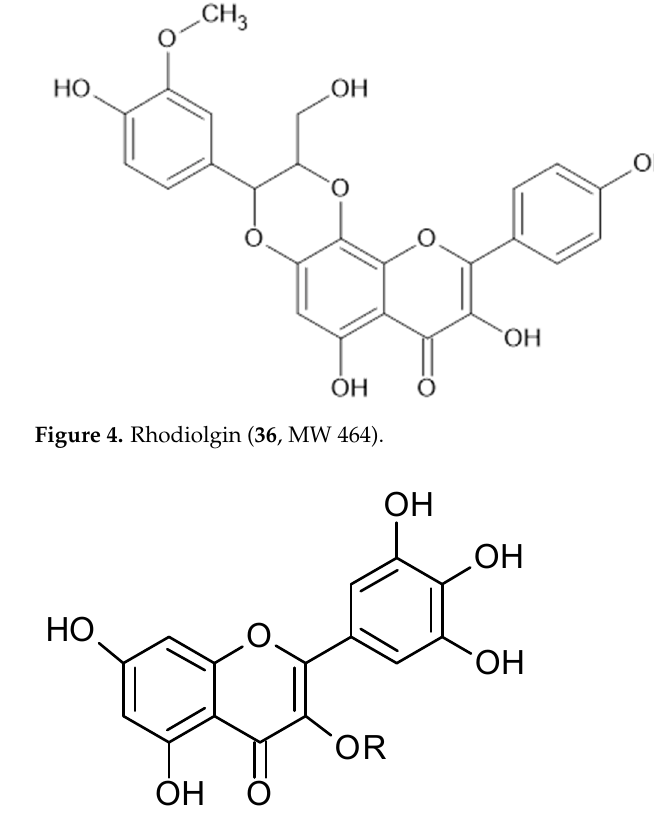
Figure 5. Chemical structure of compound 38 (R = H; MW = 318).